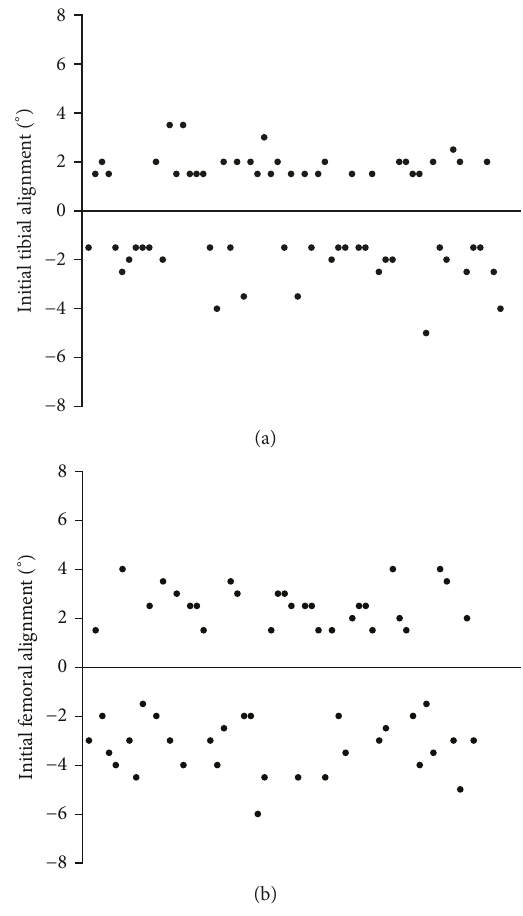
Figure 3: Initial tibial (a) and femoral (b) alignment by using the conventional extramedullary (tibia) and intramedullary (femur) alignment technique. Only cases, in which corrections were per- formed ( − varus, + valgus), are